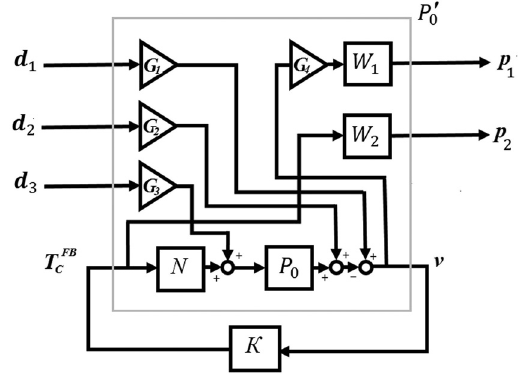
Figure 8: Augmented